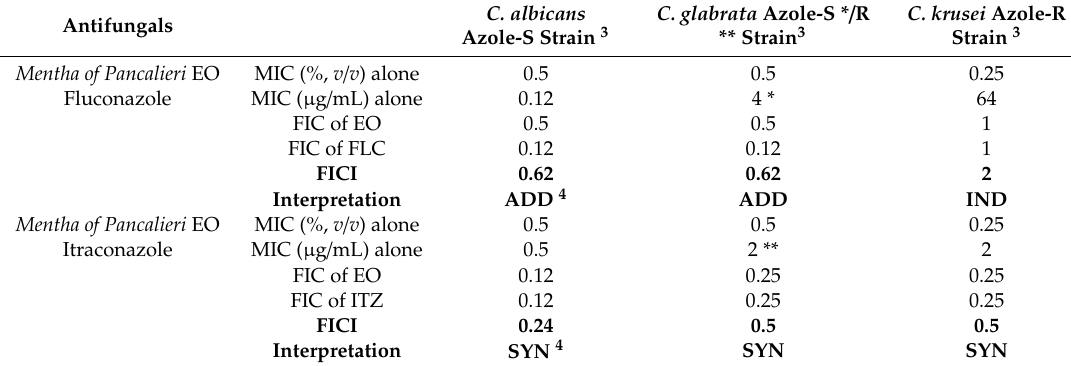
Table 4. MIC 1 and FICI 2 of the “Mentha of Pancalieri” EO plus fluconazole or itraconazole against azole-S / R Candida spp. strains.